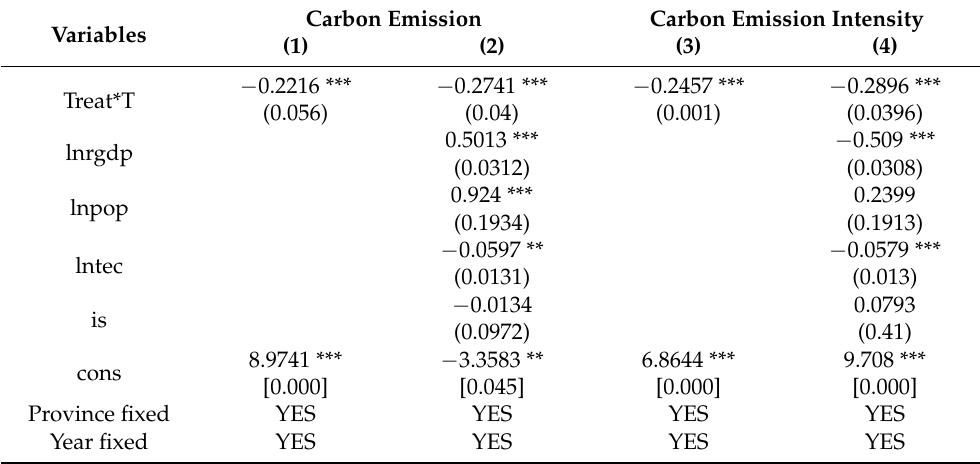
Table 4. Impact of national carbon trading policy on carbon emissions and carbon